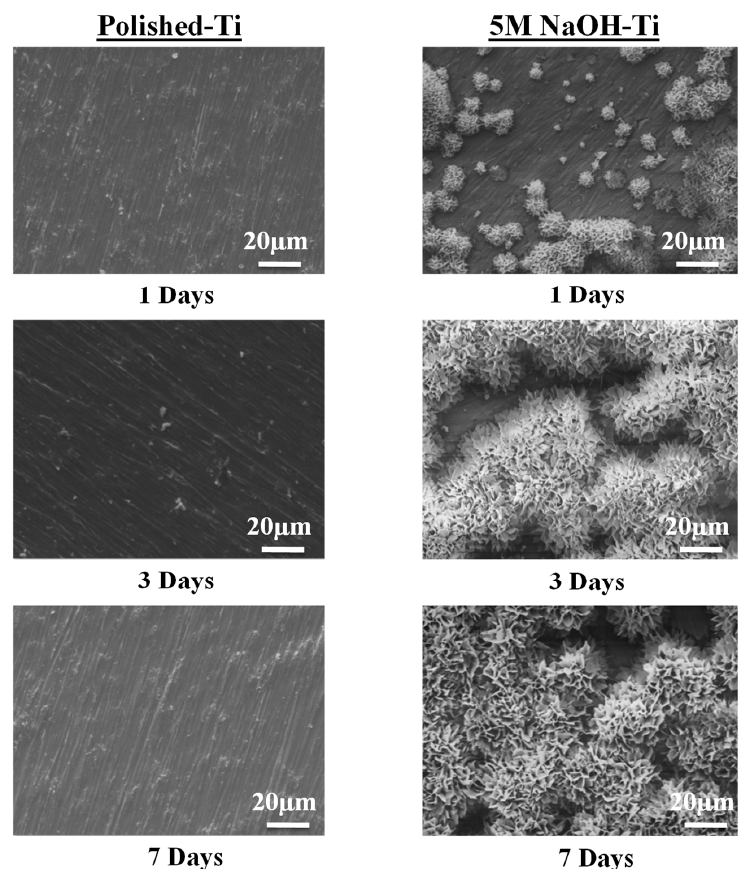
Figure 6. SEM images of the Polished ‐ Ti and Ti ‐ AT after immersion in the meta stable calcium phosphate solution at 37 °C (Ti ‐ IT37° and Ti ‐ AT ‐ IT37°). No HA spherical particles were deposited on the Ti ‐ IT37° for up to 7 days of immersion. In contrast, spherical particles consisting of plate ‐ like HA were deposited on the part of the Ti ‐ AT ‐ IT37° after immersion for 1 day.